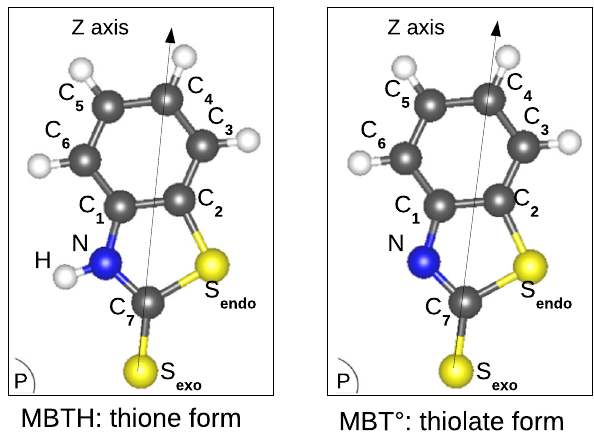
Fig. 3 MBT molecule under the thione (MBTH) and thiolate (MBT°) forms at isolated state. The Z axis passes through the S exo and C 7